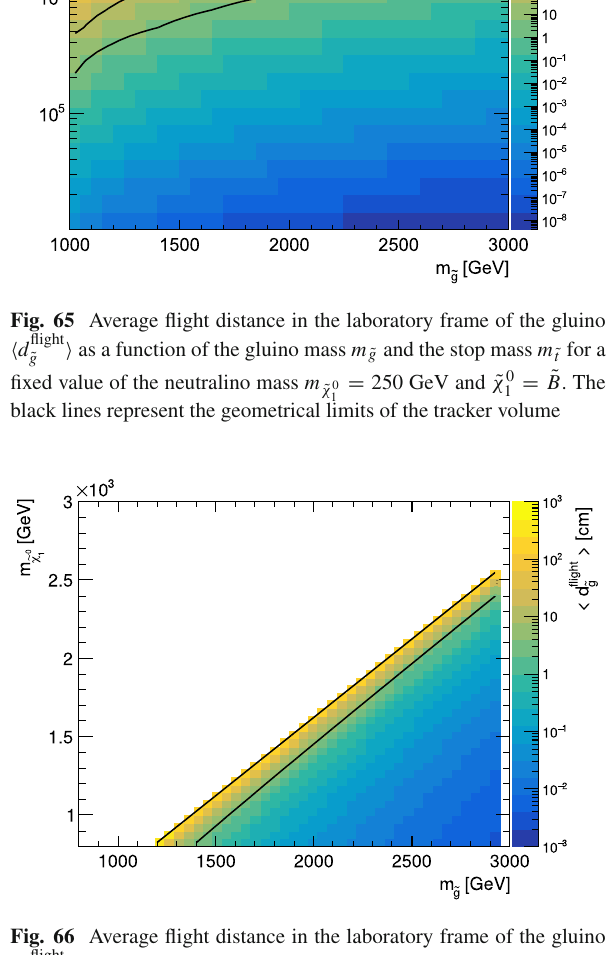
g and the neutralino mass = ˜ B . The 1 + 2 m < m ˜ t 1